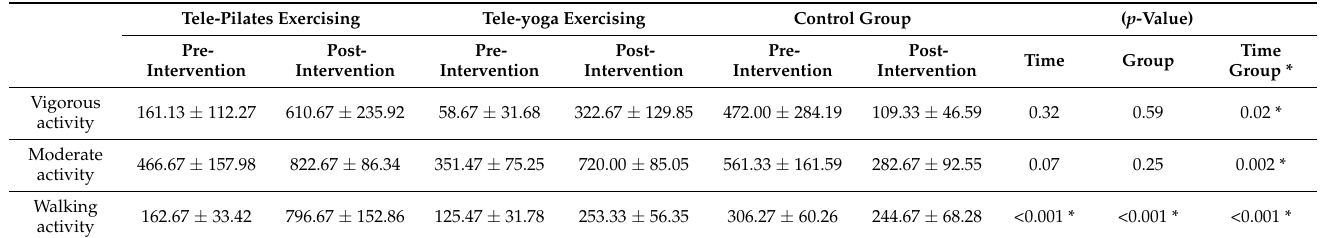
Table 3. The discrepancies of activities of each physical activity level between the